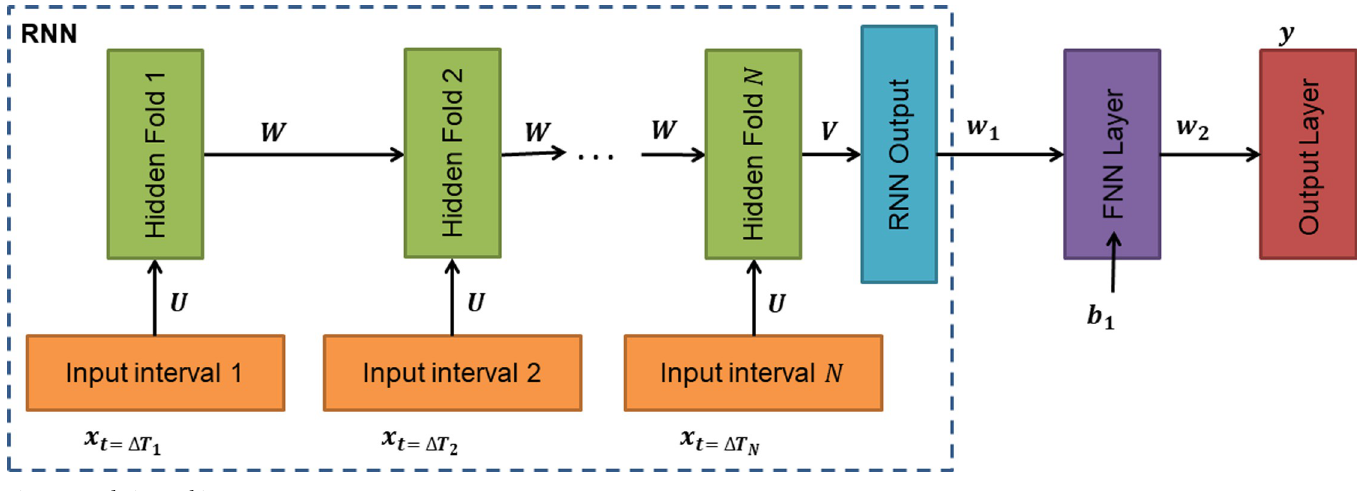
Fig 3. RNN design